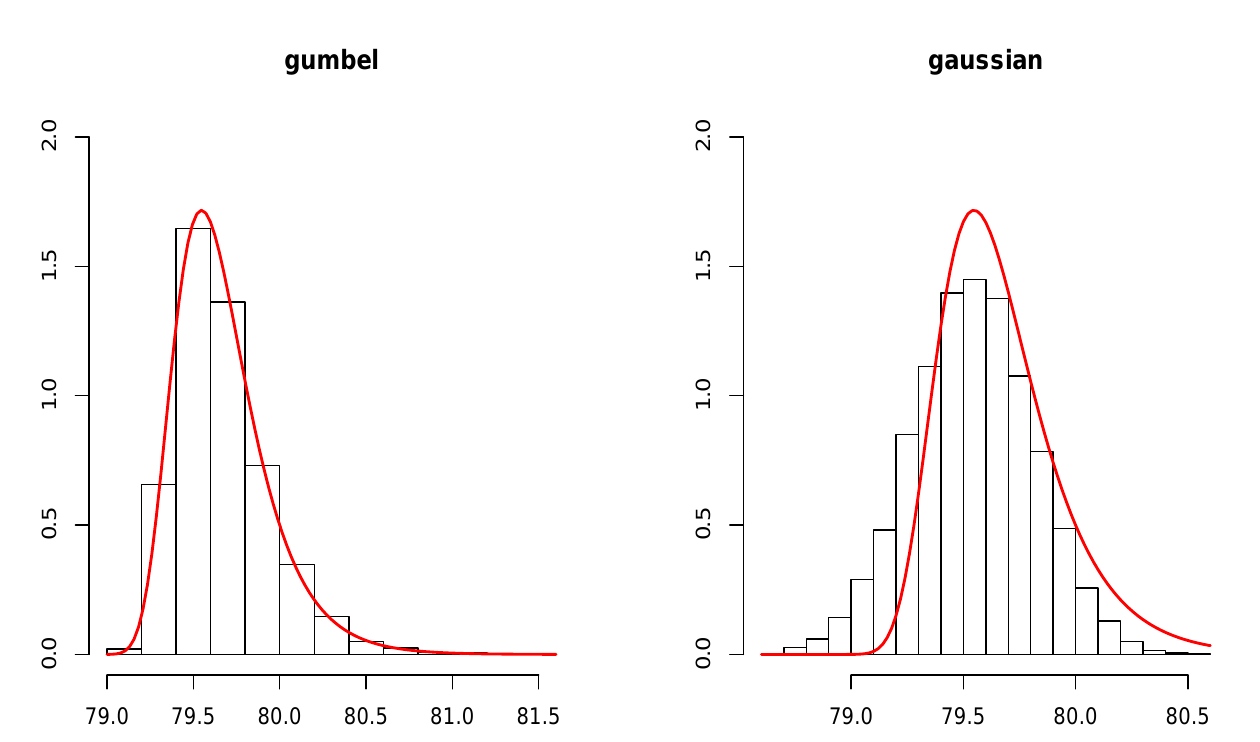
Figure 4. Conditional histograms of X t + 1 for the Gumbel model and Gaussian model for females with superimposed Gumbel density based on the estimated